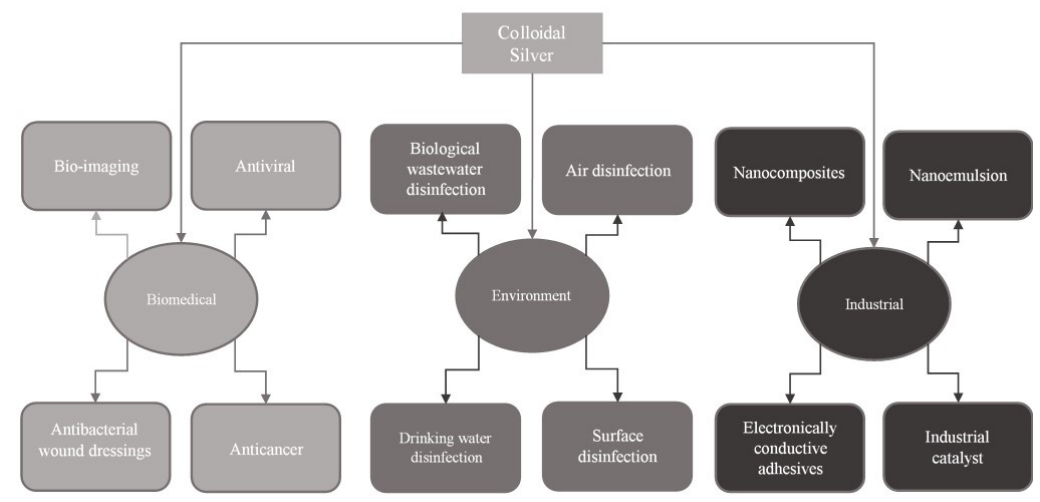
Figure 1. Silver colloidal applications.